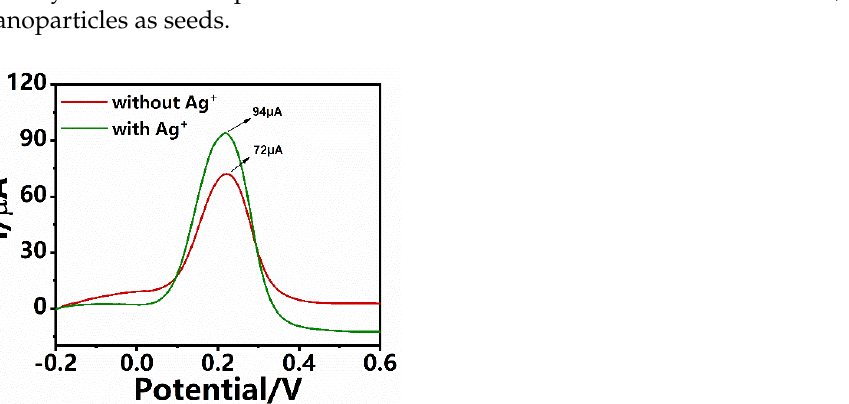
Figure 7. DPV current responses of the electrochemical sensor before and after treatment with Ag+ in 0.01M PBS (pH = 9) containing 4 mg mL –1 1-naphthalene sodium phosphate.